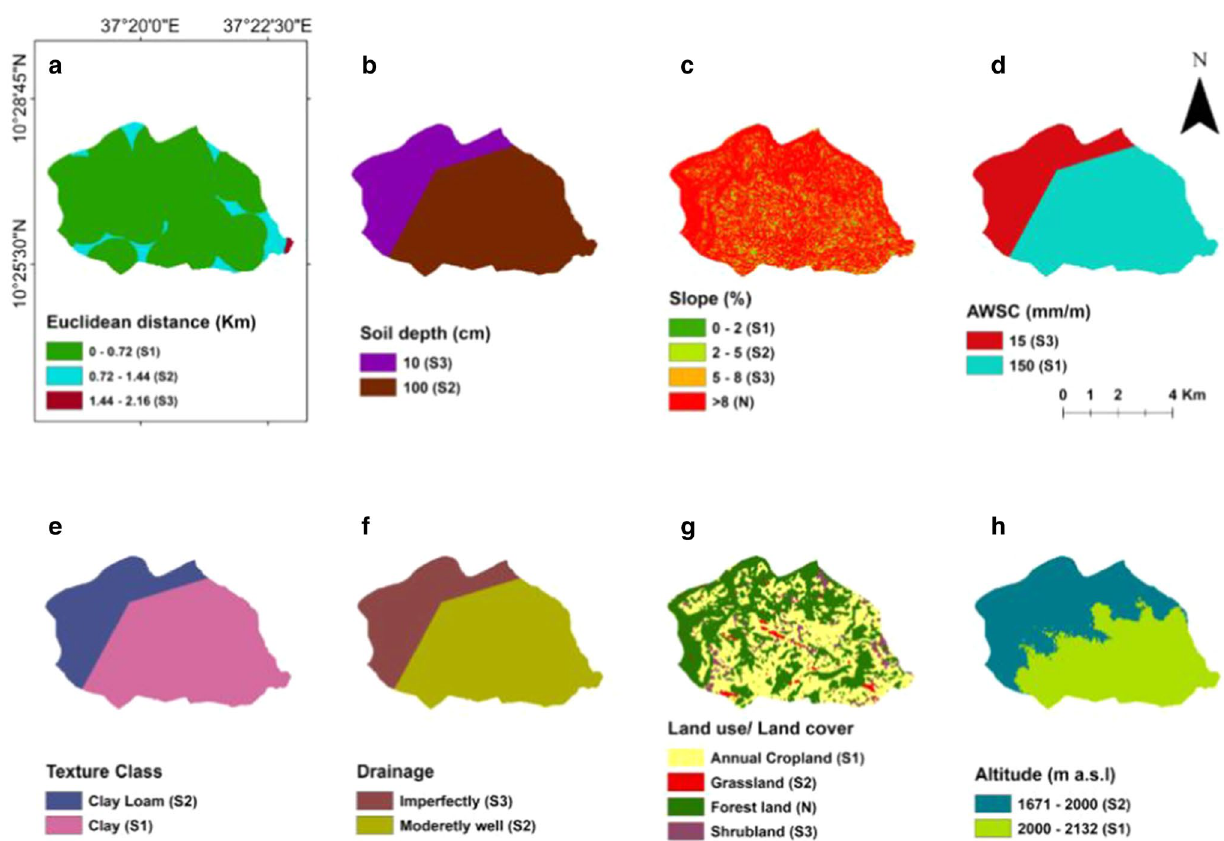
Fig. 3 Factors map and degree of suitability to assess the ideal location for surface irrigation: a Distance from water sources, b Soil Depth, c Slope, d Available water storage capacity, e Soil Texture, f Drainage, g Land use/ land cover, h Altitude